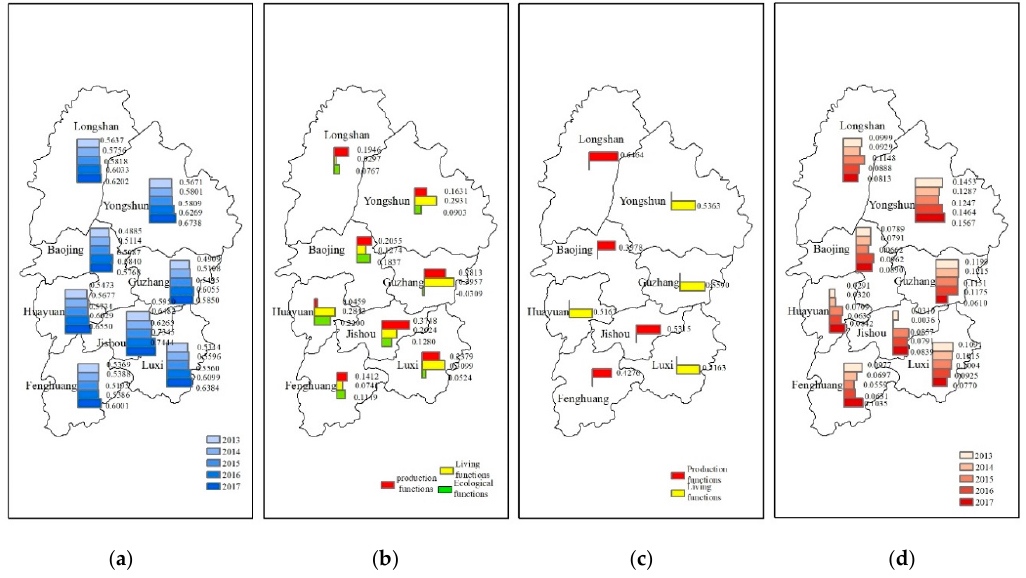
Figure 2. Changes of land use total function from 2013 to 2017 in Xiangxi. ( a ) The value of the function. ( b ) The dynamic degree. ( c ) The dynamic dominance. ( d ) The standard deviation.